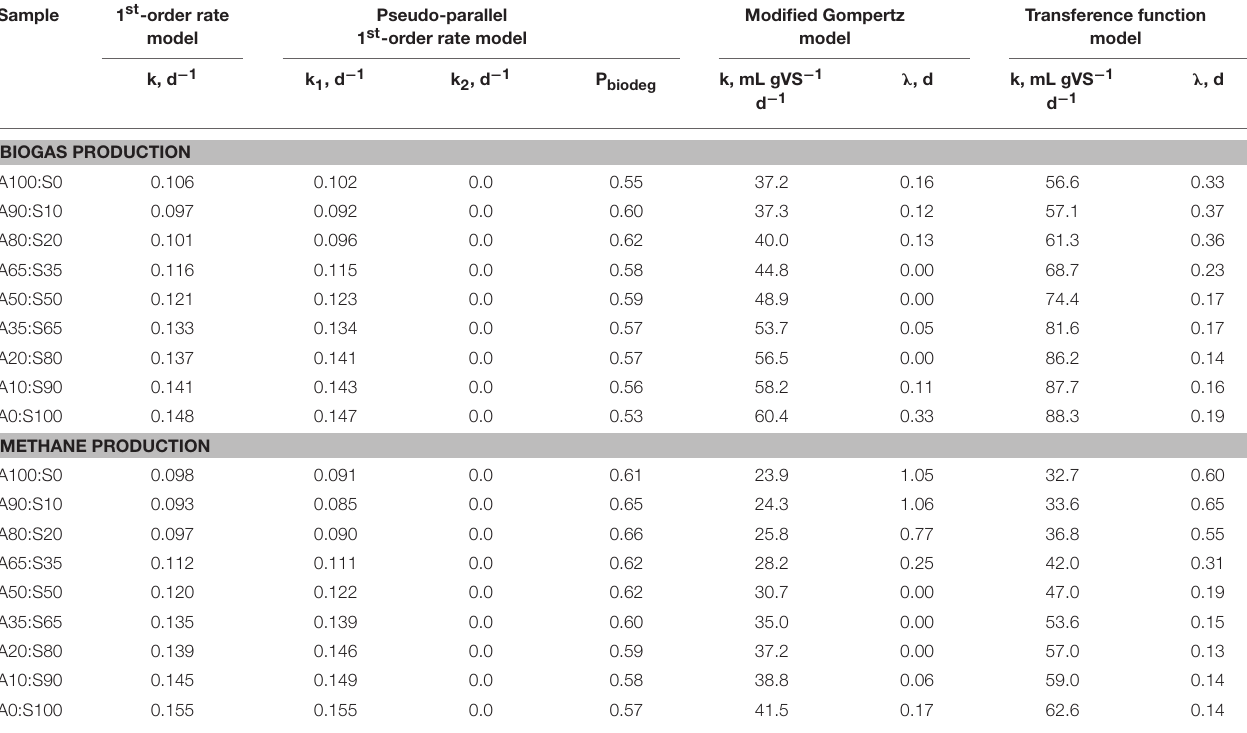
TABLE 3 | Effect of algae co-digestion with sewage sludge on biogas and methane production kinetic parameters.